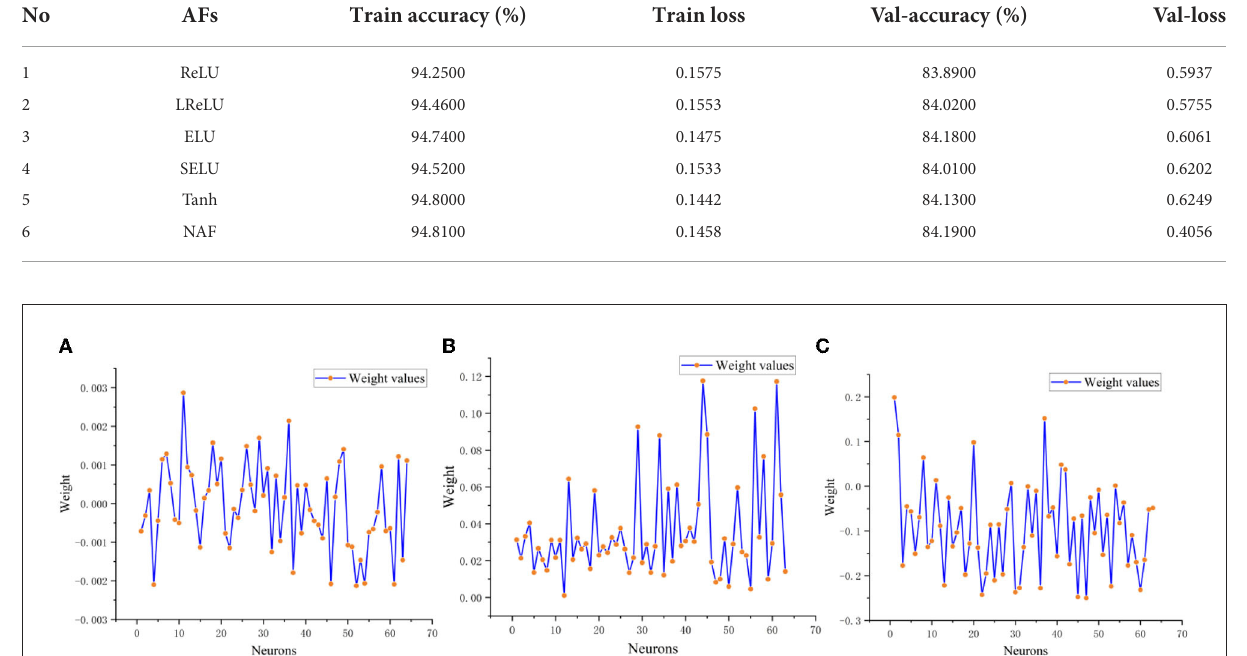
TABLE 5 GRU model with different Afs for IMDB sentiment classification.